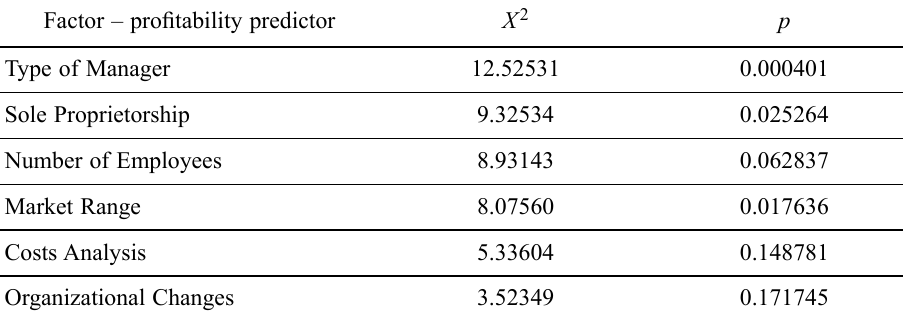
Table 4. X 2 and significance level p of the predictors of company profitability during the period of reduced economic